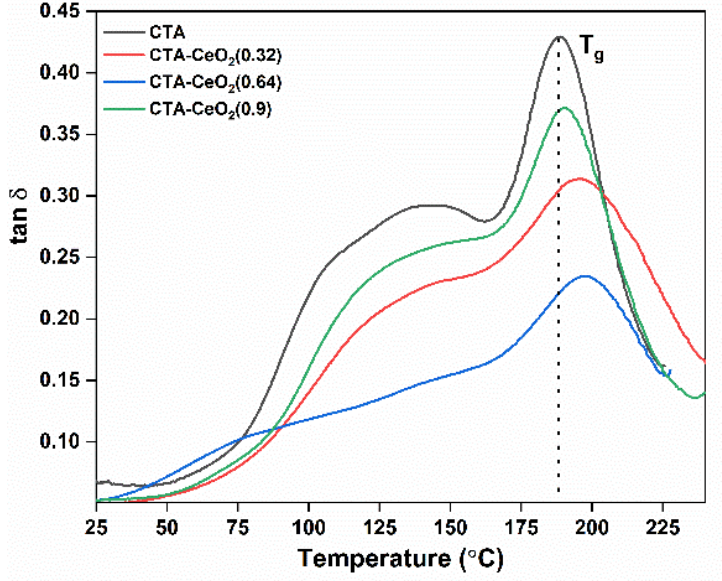
2 -modified CTA MMMs.